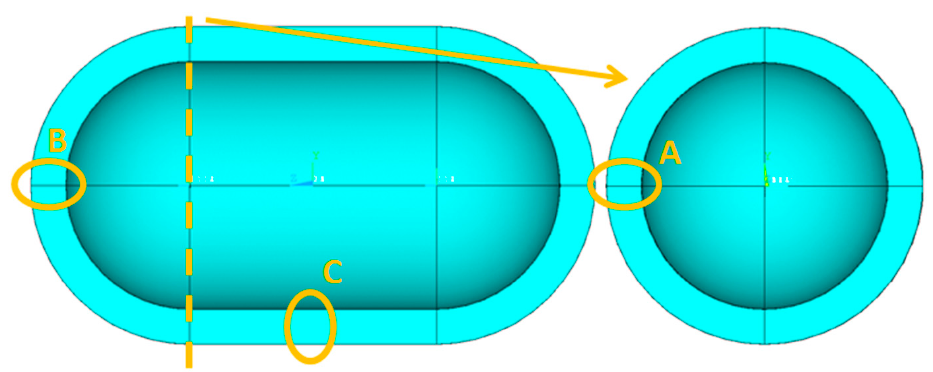
Figure 5. Points A, B, C of interest for temperature distribution calculation through the insulation thickness. Table 3. Output results for the selection of the mesh density.